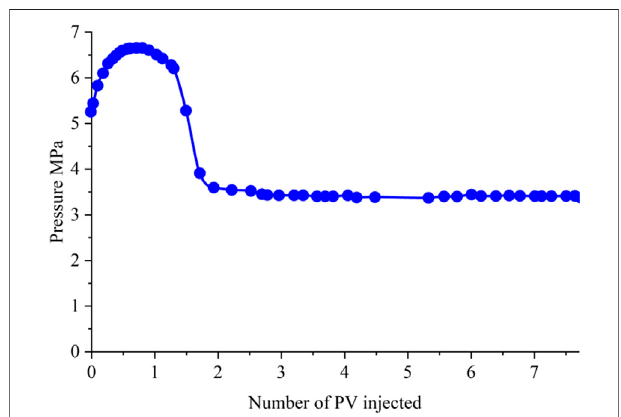
FIGURE 9 | The pressure change of the physical model.